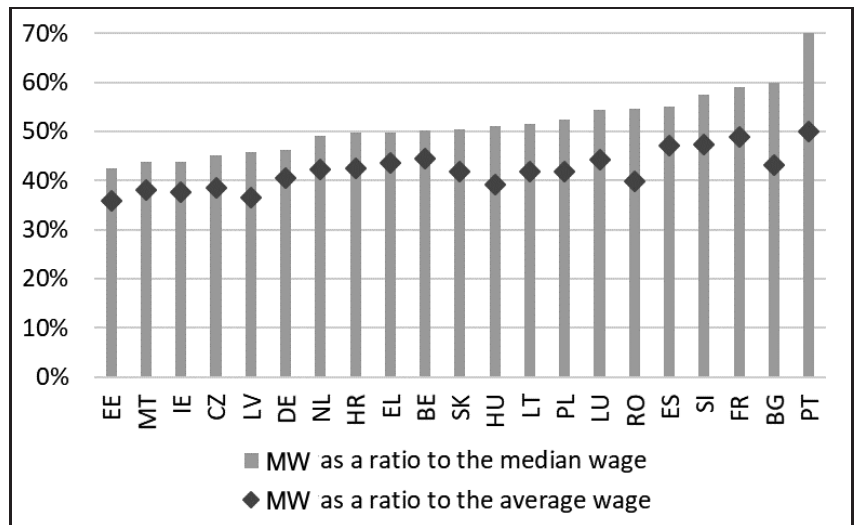
Figure 1 MWs, expressed as a percentage of the gross median and average wage of full-time workers, 2019.